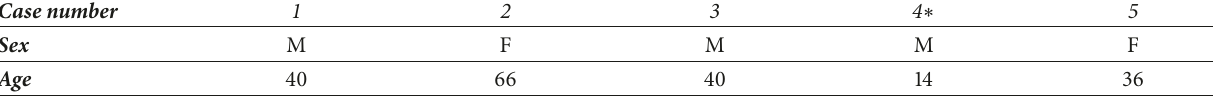
Table 1: Patient characteristics, treatments, clinical parameters, and patient outcome. M: male, F: female, Cat-free: catecholamine-free, CRRT: continuous renal replacement therapy, SOFA: Sequential Organ Failure Assessment, and PELOD: Paediatric Logistic Organ Dysfunction ( ∗ only case